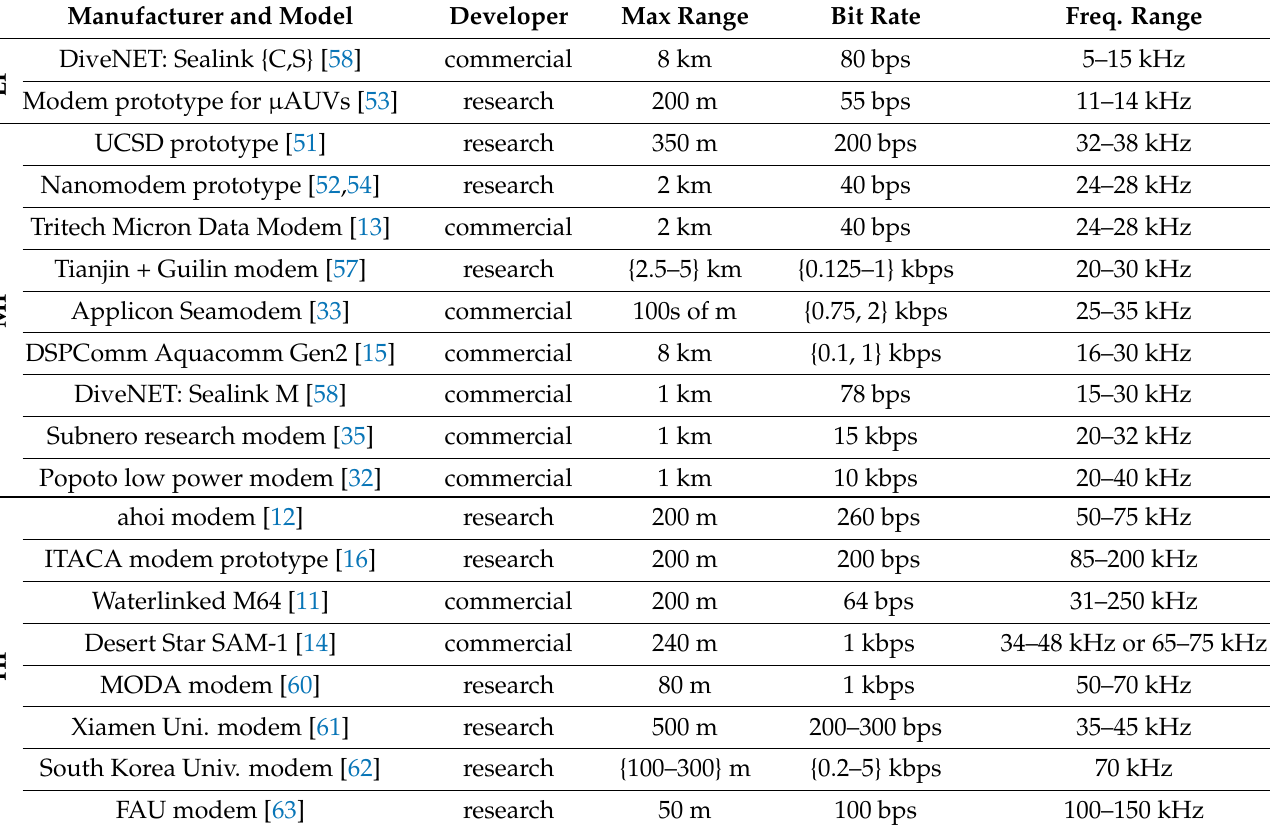
Table 1. Summary of state-of-the-art of affordable acoustic